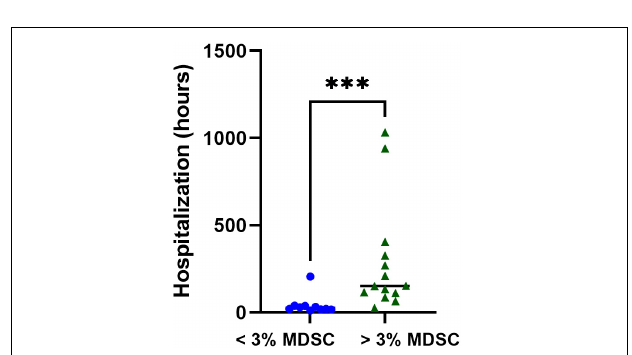
FIGURE 6 | Associations with T-MDSC and duration of hospitalization in children with symptomatic SARS-CoV-2. Increased initial% T-MDSC was associated with longer hospitalization in children admitted with COVID compared to those with lower circulating % T-MDSC. Mann-Whitney test was performed, data represent medians with IQR values. *** p =